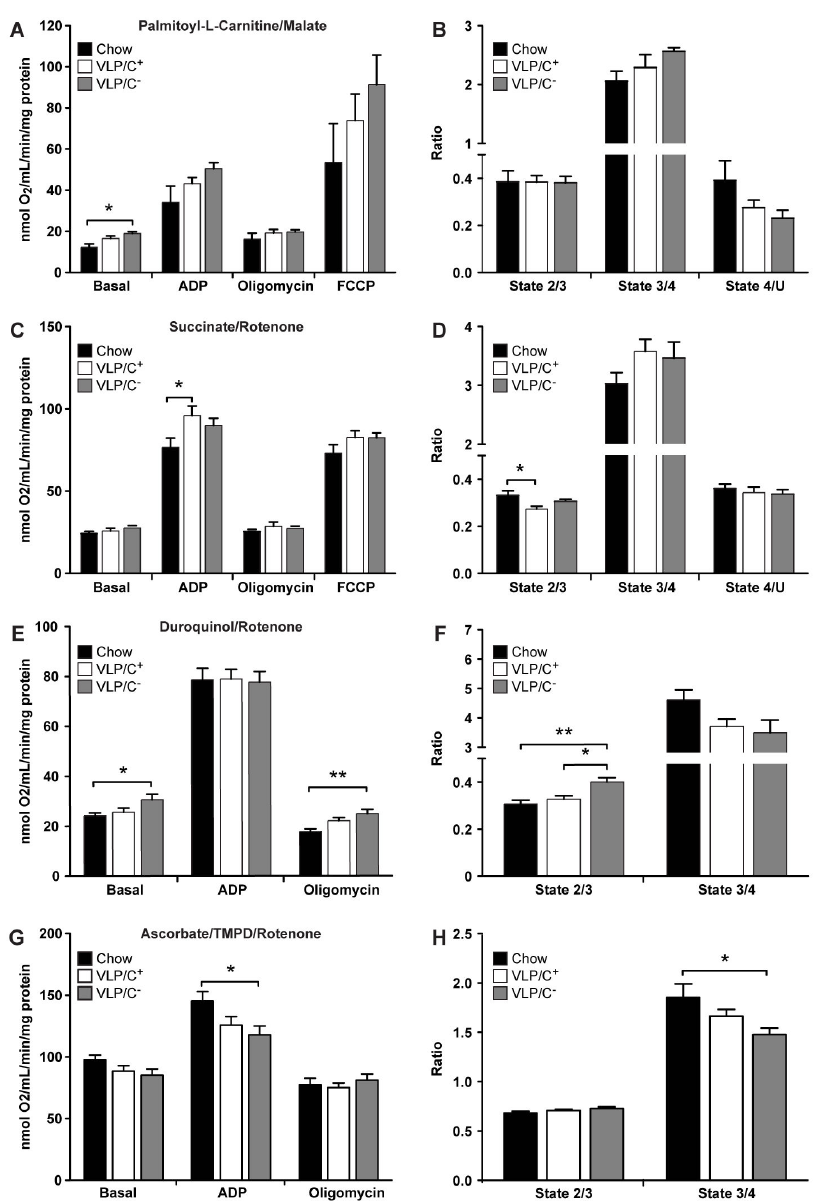
Figure 8. Respiration studies of hepatic mitochondria isolated from mice fed very low protein and carbohydrate, very high fat diets. ( A ) Respiration rates in the basal leak condition (state 2), ADP-stimulated condition (state 3), F condition (state 4), and uncoupled condition in hepatic mitochondria isolated from chow-fed, VLP/C + -fed, and VLP/C - -fed (for 6 weeks) mice using palmitoyl-L-carnitine and malate as substrates. n =4 mice/group. ( B ) Relative respiratory ratios of basal leak (state 2/state 3), respiratory control (RCR, state 3/state 4), and coupling control (CCR, state 4/uncoupled), derived from panel A. ( C ) Respiration rates in states 2-4 and while uncoupled in hepatic mitochondria isolated from chow-, VLP/C + , and VLP/C - -fed mice that respired using the Complex II-electron donor substrate succinate in the presence of rotenone (Complex I activity inhibitor). n=9 mice/group. ( D ) Relative respiratory ratios of state 2/state 3, state 3/state 4, and state 4/uncoupled, derived from panel C. ( E ) Respiration rates in states 2-4 in hepatic mitochondria isolated from chow-, VLP/C + , and VLP/C - -fed mice that respired using the Complex III-donor substrate duroquinol plus rotenone. n=9 mice/group. ( F ) Relative respiratory ratios of state 2/state 3, state 3/state 4, and state 4/uncoupled, derived from panel E. ( G ) Respiration rates in states 2-4 in hepatic mitochondria isolated from chow-, VLP/C + , and VLP/C - -fed mice that respired using the Complex IV-donor substrate combination TMPD/ascorbate, plus rotenone. n=9 mice/group. ( H ) Relative respiratory ratios of state 2/state 3, state 3/state 4, and state 4/uncoupled, derived from panel G. Data are presented as means±SEM. * p ≤0.05; ** p ≤0.01 by 1-way ANOVA with Tukey’s post hoc testing. doi: 10.1371/journal.pone.0074806.g008 PLOS ONE |